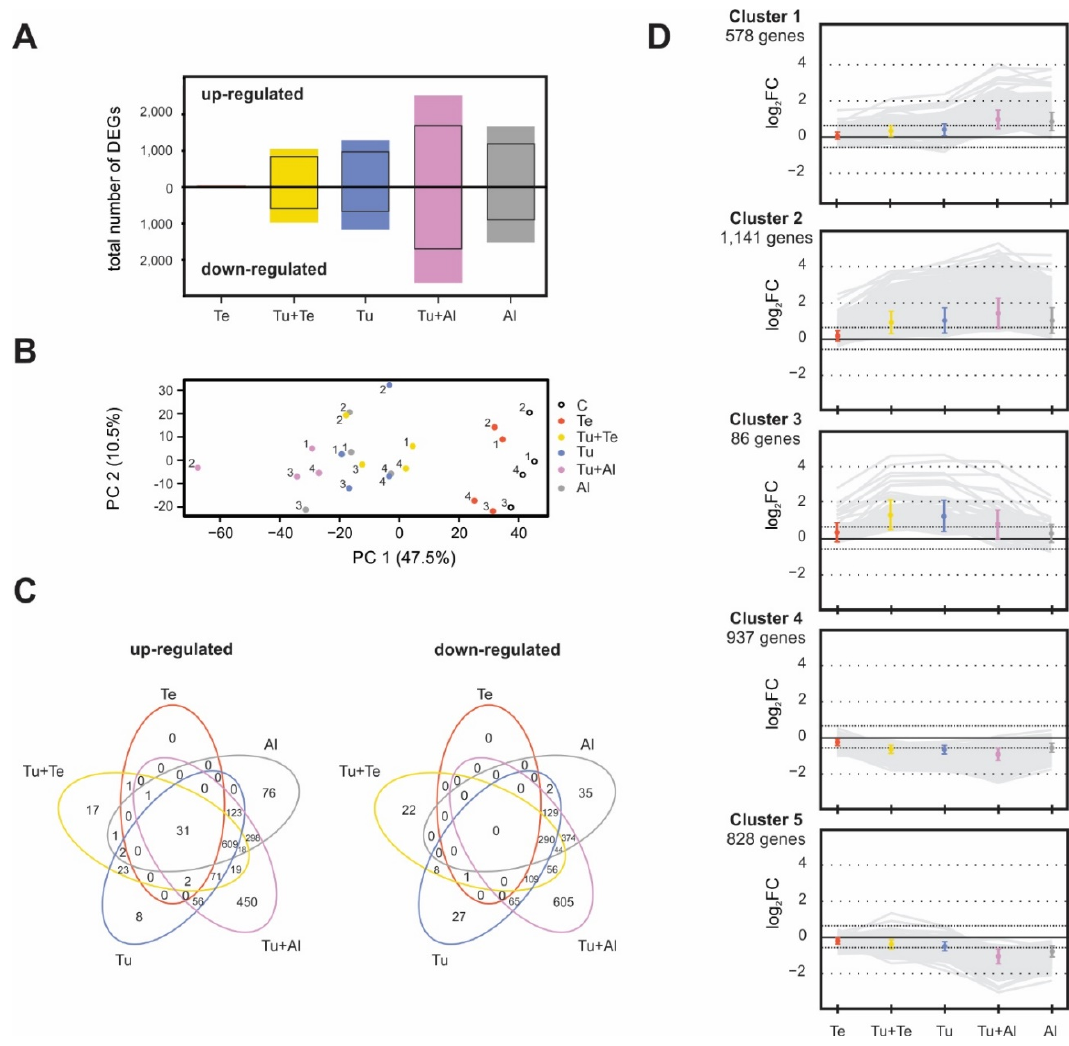
Figure 2. General overview of transcriptional responses in tomato ( Solanum lycopersicum ) leaves after seven days of infestation with herbivorous mites. Tomato leaves were infested with either a single mite species ( Tetranychus urticae (Tu), Tetranychus evansi (Te), or Aculops lycopersici (Al)) or two species simultaneously ( T. urticae plus T. evansi (Tu+Te), or T. urticae plus A. lycopersici (Tu+Al)). Non-infested plants served as controls (C) and were used as a common reference in the transcriptional comparisons. ( A ) The total numbers of differentially expressed genes (DEGs) across the five mite feeding regimes. Bars represent the number of up- or down-regulated tomato genes identified based on a Benjamini and Hochberg false discovery rate adjusted p ≤ 0.05. The black-lined sections within the bars indicate the number of up- or down-regulated tomato genes with an absolute fold change (FC) ≥ 1.5 (i.e., Log 2 FC ≥ 0.585). ( B ) Principal component analysis plot of the tomato transcriptomic responses to the five mite feeding regimes. ( C ) Venn-diagrams showing the overlap of the tomato transcriptomic responses to the five mite feeding regimes for up-regulated and down-regulated genes. ( D ) Transcriptional patterns of the five clusters of tomato DEGs across the five mite feeding regimes. Colored diamonds in each plot represent the average (±SD) of the transcript levels per feeding regime. The Log 2 FC cutoff value of 0.585 is depicted by dashed lines. The five clusters were identified using a k -means clustering approach.